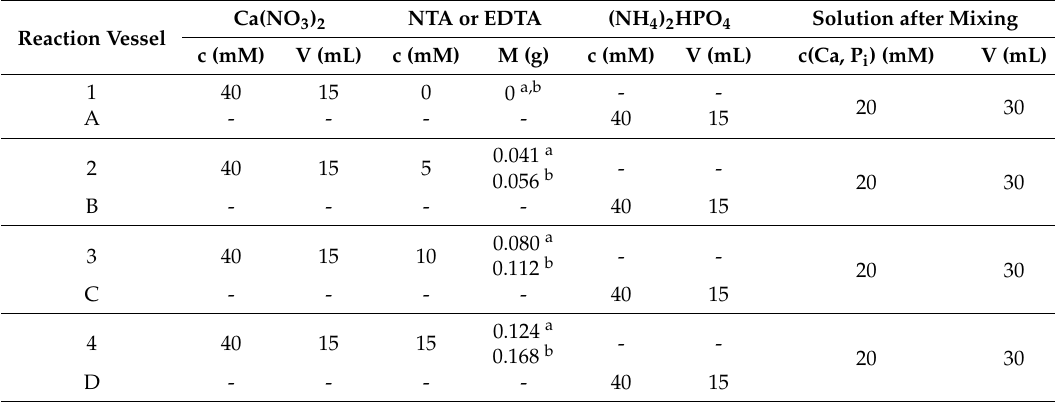
Table 2. Concentrations, masses, and volumes used for pH and conductivity measurements during CP